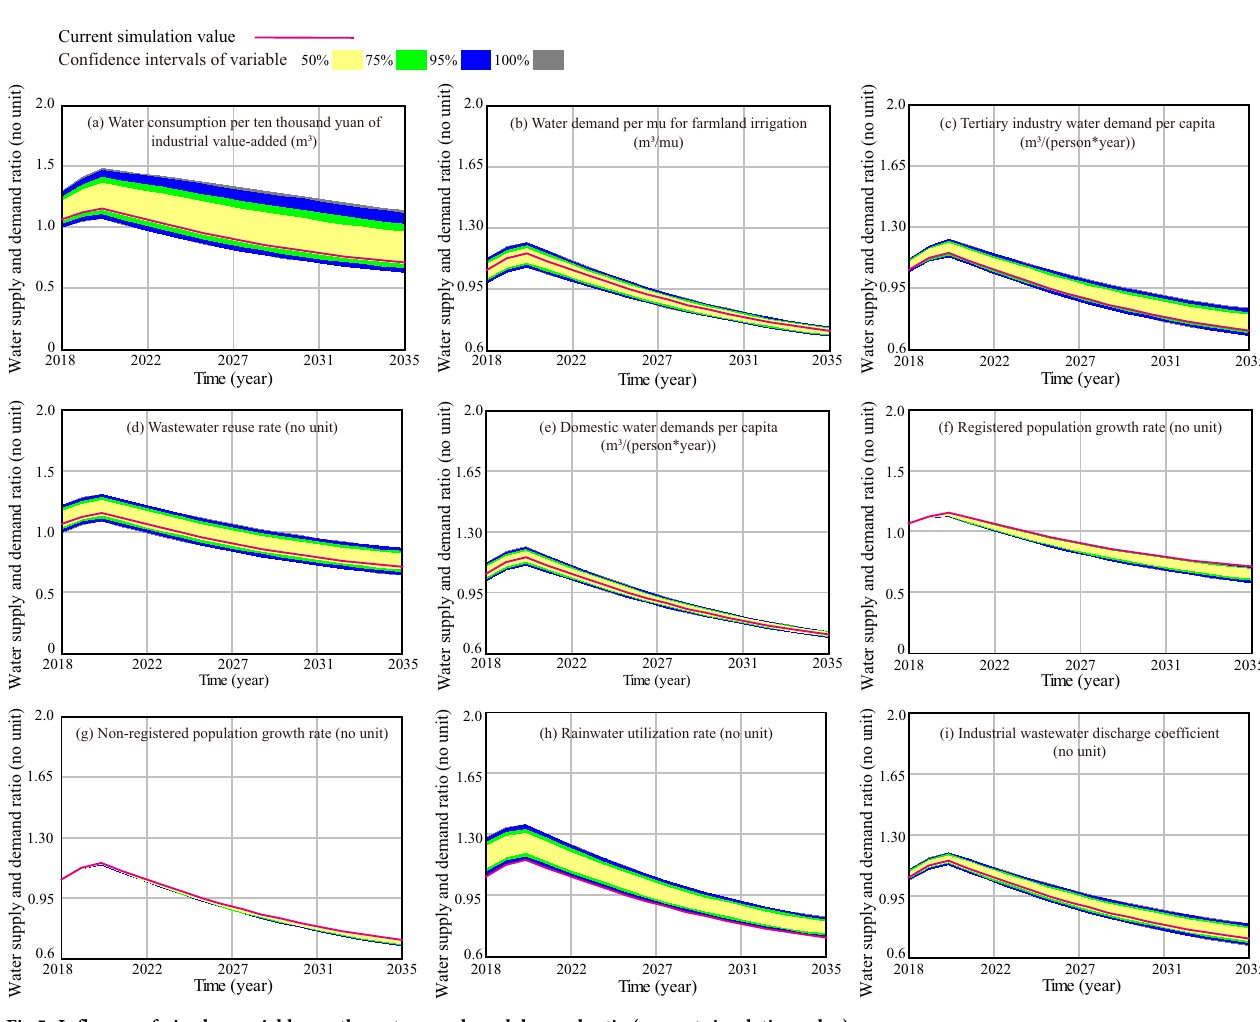
Fig 5. Influence of nine key variables on the water supply and demand ratio (current simulation